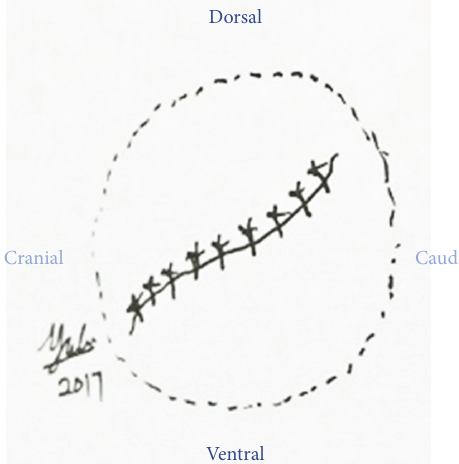
Figure 10: Periocular skin closure was done by 2.0 PDS in inter- rupted suture pattern.